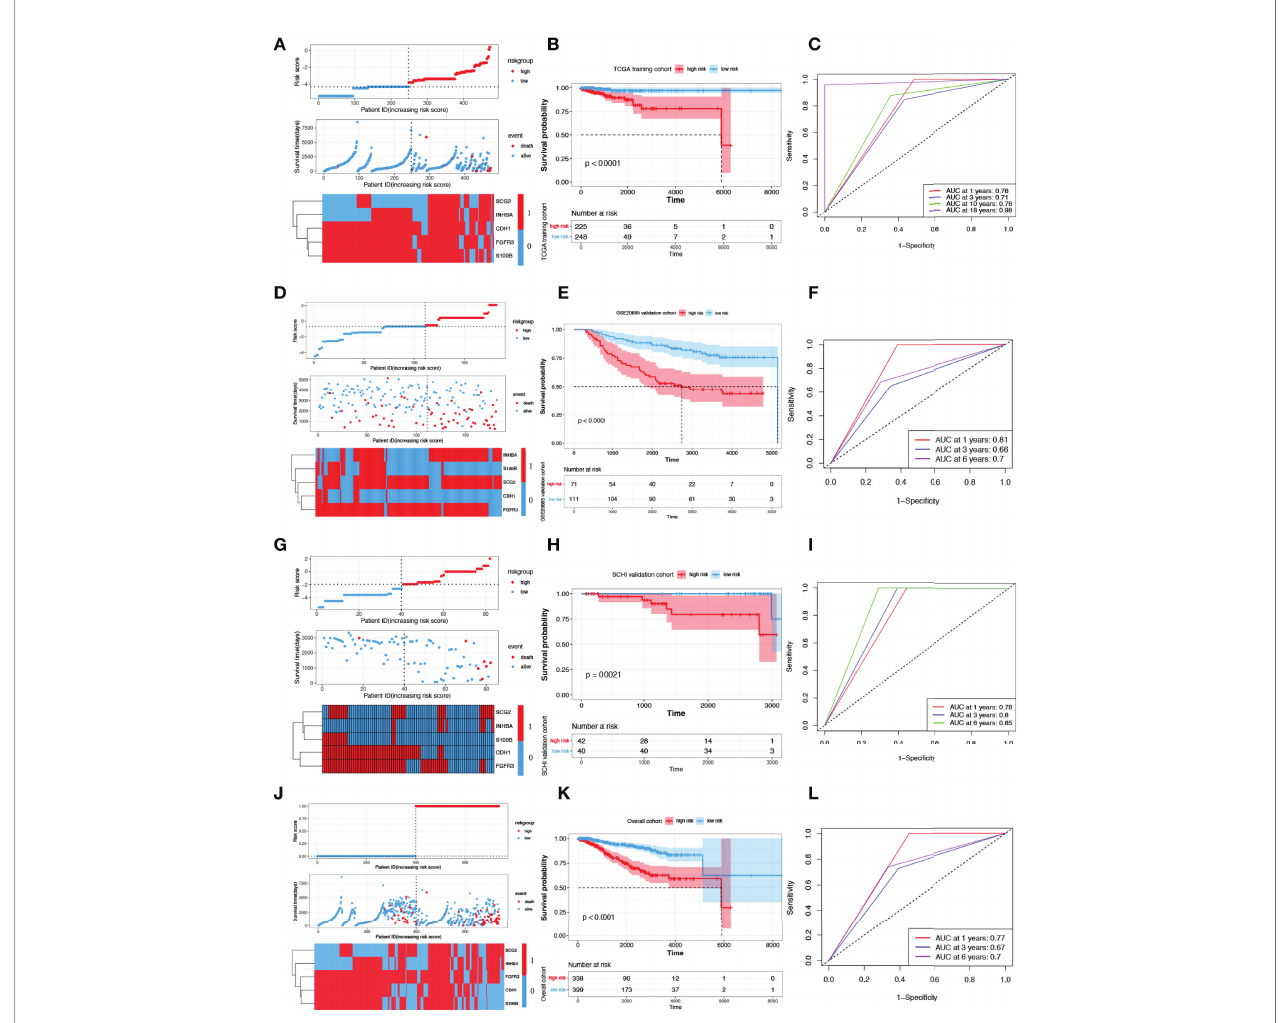
FIGURE 4 | Construction and validation of risk scoring models. (A) Distribution of risk score, survival status, and the expression of fi ve prognostic IRGs in TCGA training cohort. (B, C) OS curves for patients in different subgroups and AUCs in TCGA training cohort. Presentation of the above parameters in the GSE20685 validation cohort (D – F), in the SCHI validation cohort (G – I) and in the overall cohort (J – L) . IRG, immune-related gene; AUC, area under the